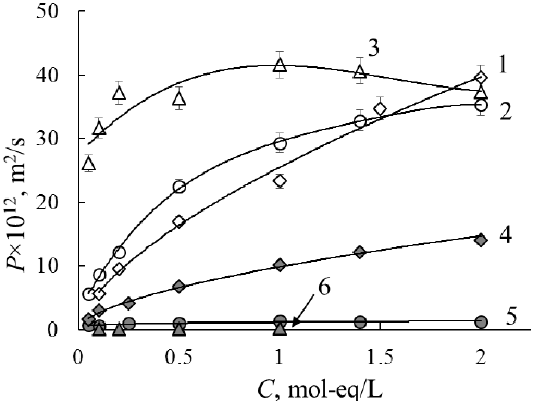
Membranes 2021 , 11 , x FOR PEER REVIEW 7 of 21 Figure 2. Diffusion permeability (DP) concentration dependencies for the MF-4SK (curves 1–3) and MF-4SK/PANI (curves 4–6) membranes in HCl (1, 4), NaCl (2, 5) and CaCl 2 (3, 6) solutions.